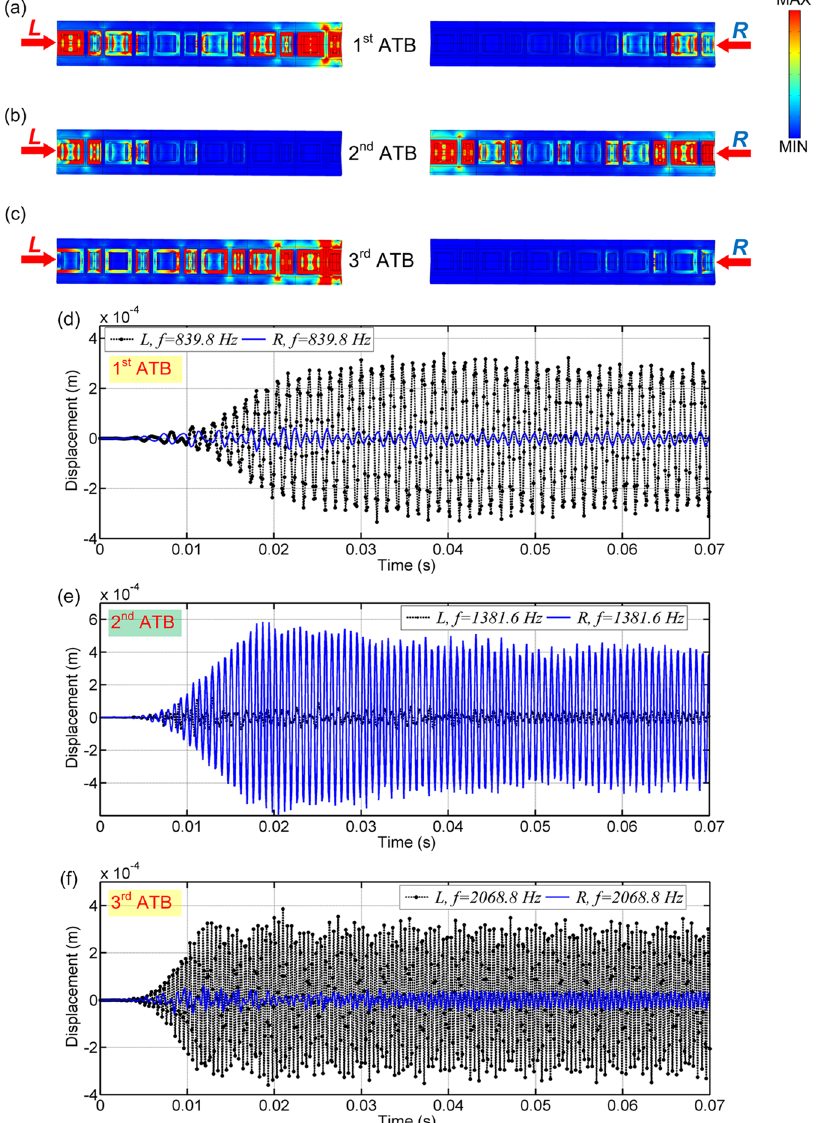
Figure 4. Snapshots of von Mises stress contours captured at the peak frequencies in the ( a ) 1 st , ( b ) 2 nd and ( c ) 3 rd ATBs for the structure consisting of 6 unit cells. Displacement-time profiles recorded at the 6 th unit cell away from the different input ends under the excitation frequencies of ( d ) 839.8 Hz, ( e ) 1381.6 Hz and ( f ) 2068.8